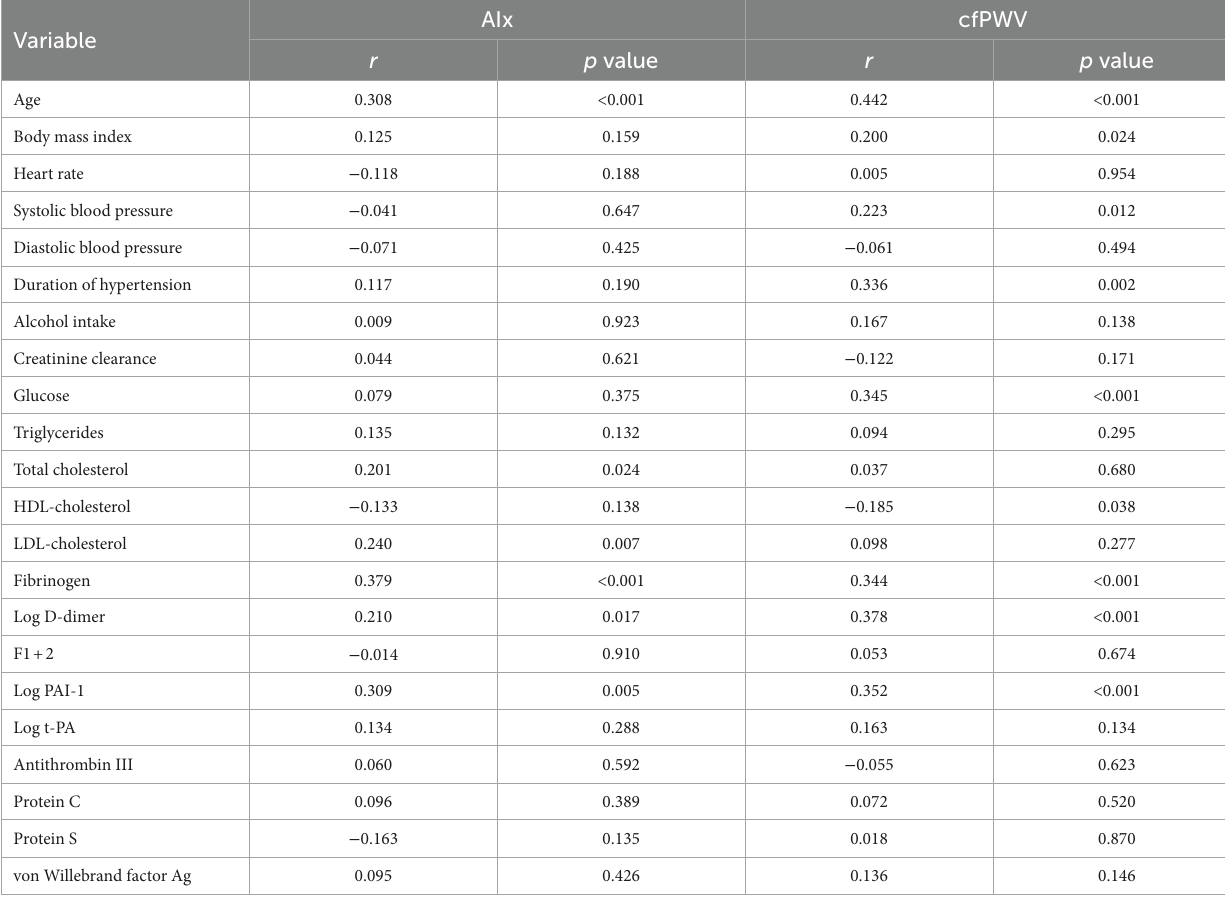
Variables with skewed distribution were log transformed for analysis. HDL, high-density lipoprotein; LDL, low-density lipoprotein; F1 + 2, prothrombin fragment 1 + 2; PAI-1, plasminogen activator inhibitor-1; t-PA, tissue-plasminogen activator.